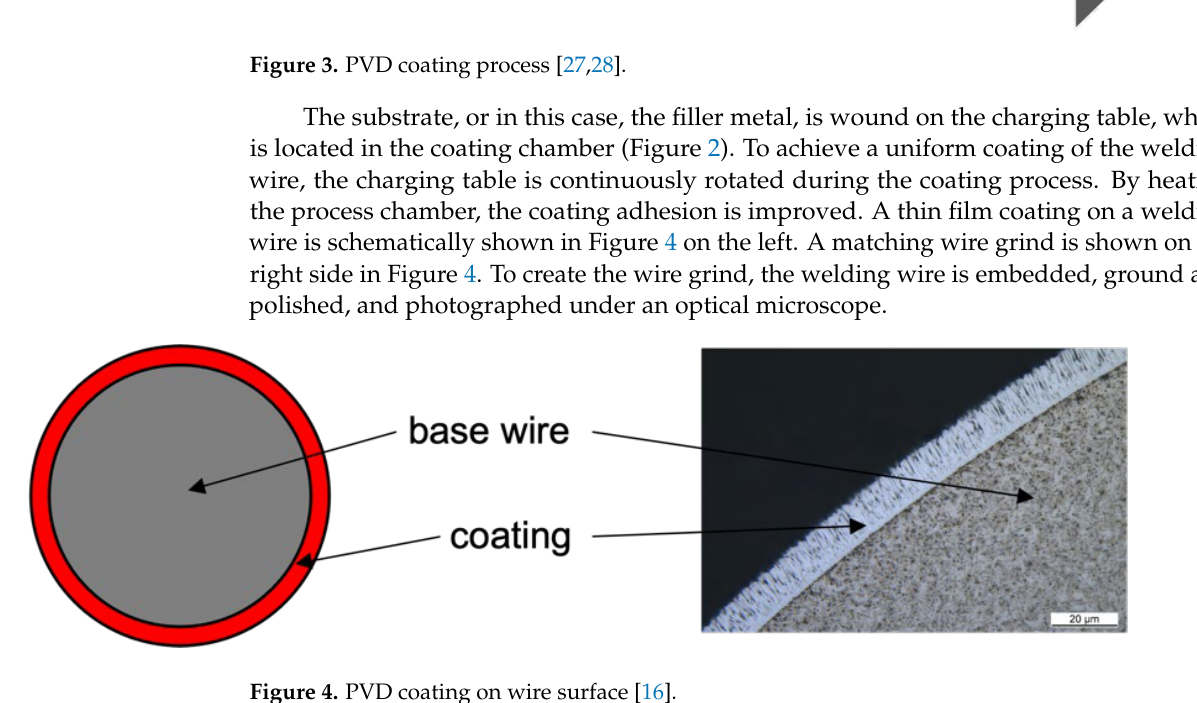
Figure 4. PVD coating on wire surface [16].